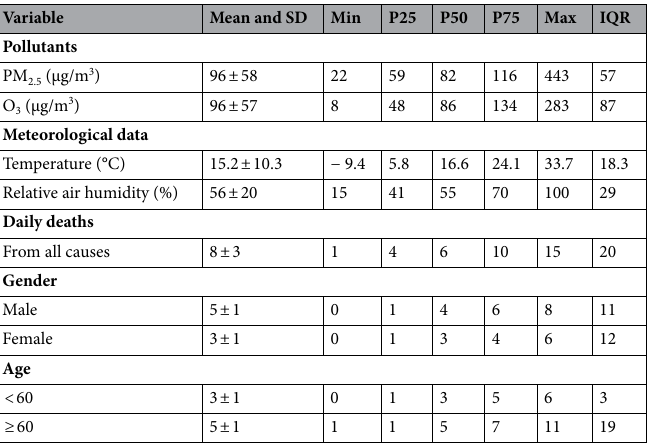
Table 1. Daily distribution of air pollutant levels, weather parameters, and deaths in Jinan, China, from 2013 to 2015.